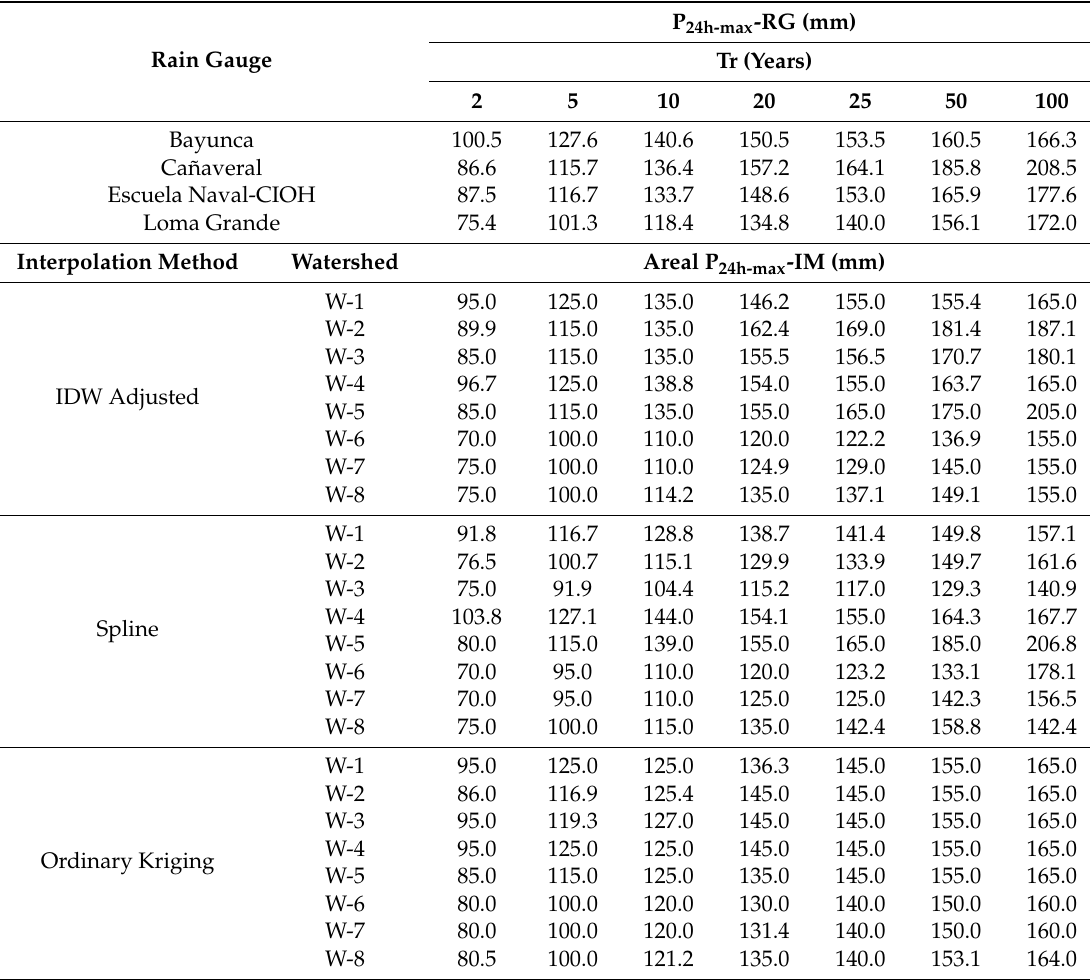
Table 8. Values of P 24h-max -RG and areal P 24h-max -Interpolation Method